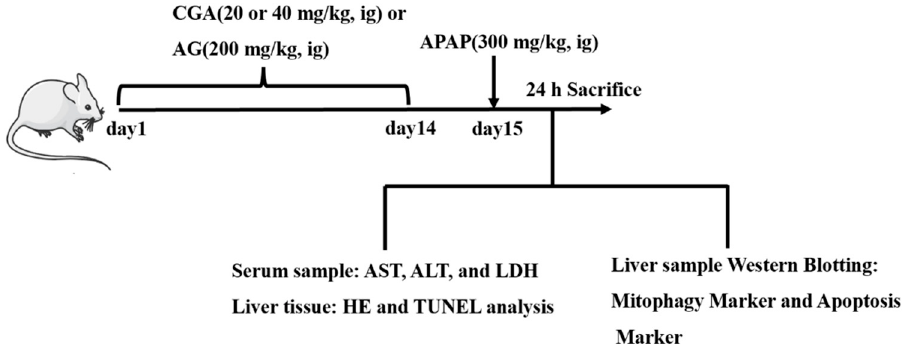
Figure 2. A schematic diagram of the treatment schedule.